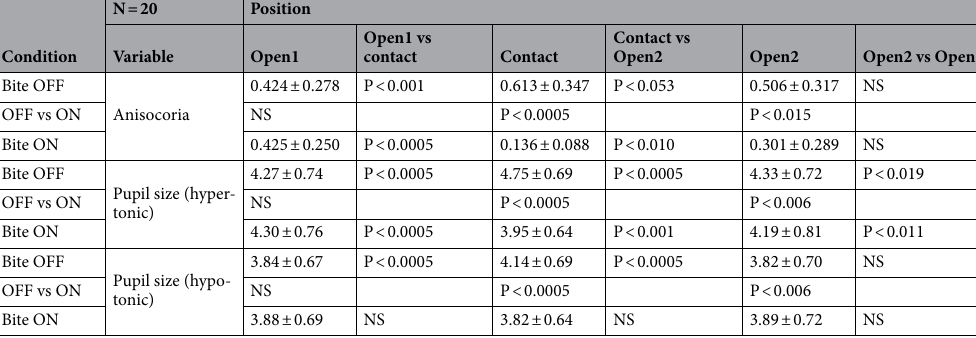
Table 2. Mean ± SD of anisocoria at rest and during haptic task in the different conditions (Bite ON, Bite OFF) and positions (Open 1–2, Contact) have been recorded in 20 subjects showing an asymmetric masseter EMG activity during clenching.